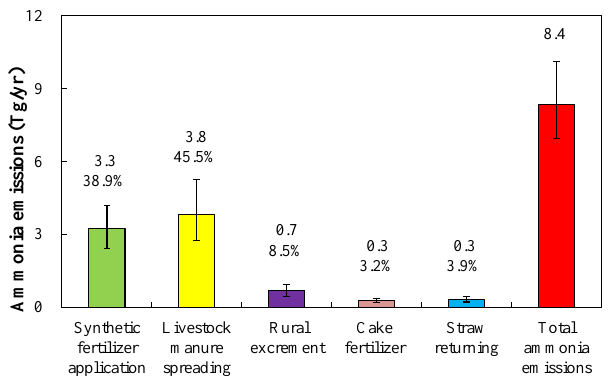
Figure 1. NH 3 emissions from CAF for 2008 by source, and the associated